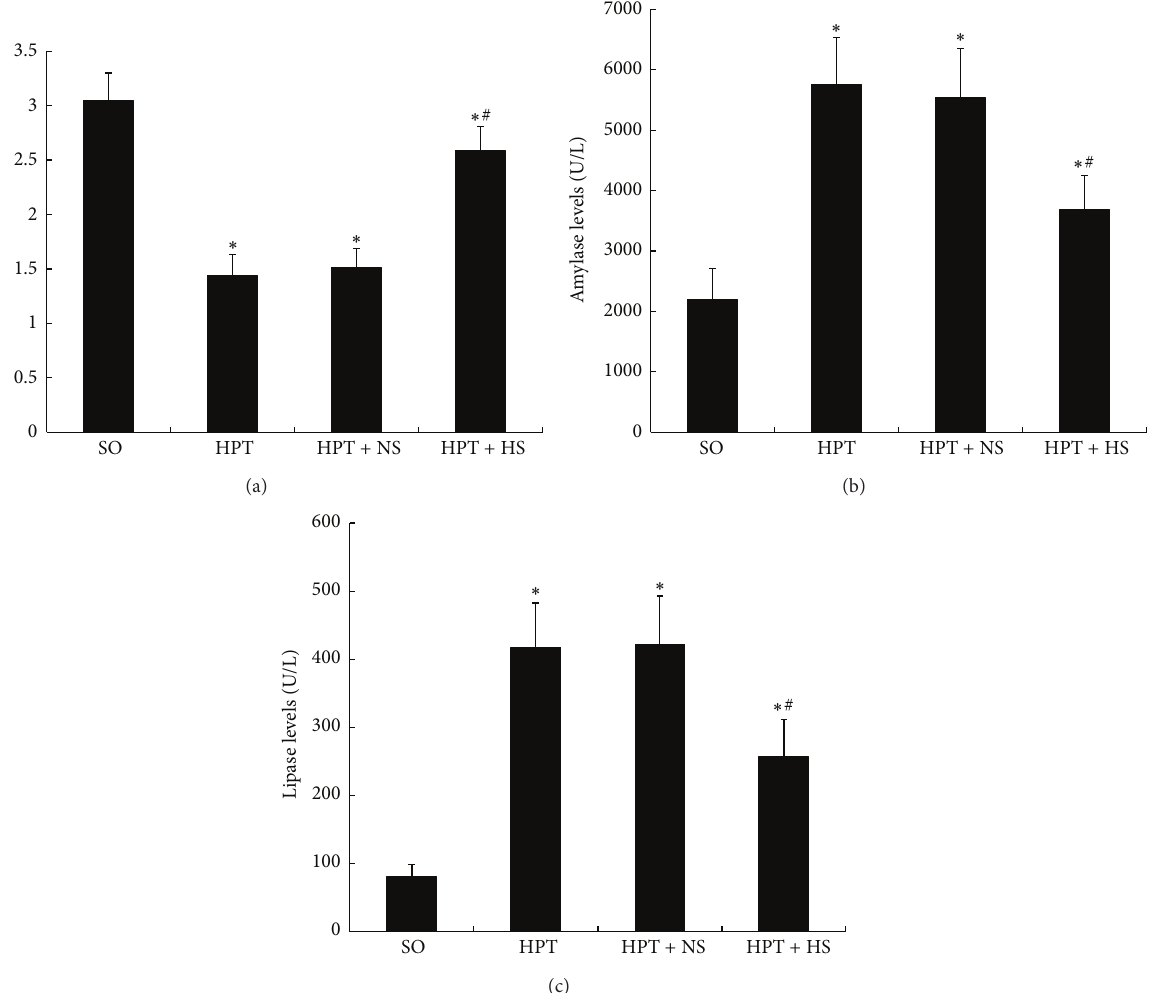
Figure 2: Changes in insulin (a), amylase (b), and lipase (c) serum concentrations in rats exposed to various treatments. As with the results of oxidative stress after I/R injury, the levels of insulin were decreased, whereas the levels of amylase and lipase were increased. The treatment with hydrogen-rich saline reverted those parameters to basal levels. ∗ 𝑃 < 0.05 compared with the SO group; # 𝑃 < 0.05 compared with the HPT + NS